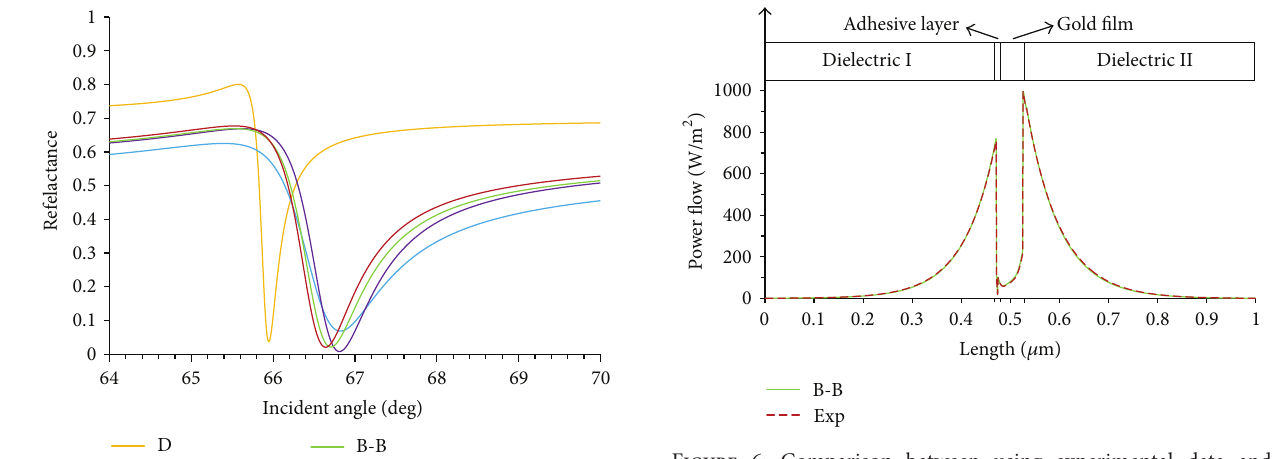
Figure 6: Comparison between using experimental data and Brendel-Bormannmodelatenergydensitytimeaveragedistribution of the